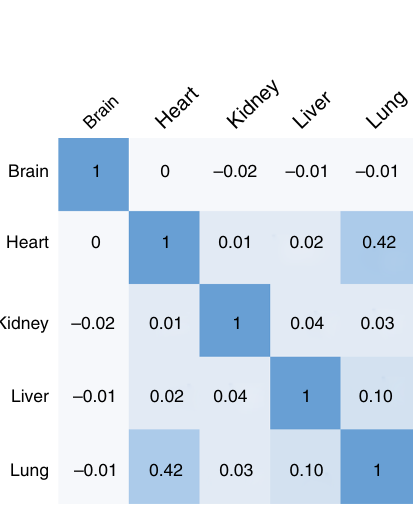
Met (M +15.995 Da), acetylation on protein N-term (+42.011 Da). The N- glycosylation sequon (N-X-S/T, X ≠ P) was modi fi ed by changing ‘ N ’ to ‘ J ’ (the two shared the same mass). The glycan database was extracted from GlycomeDB (www. glycome-db.org), total entries of N-glycan were 7884 by considering NeuGc. The protein databases used were different for each sample: